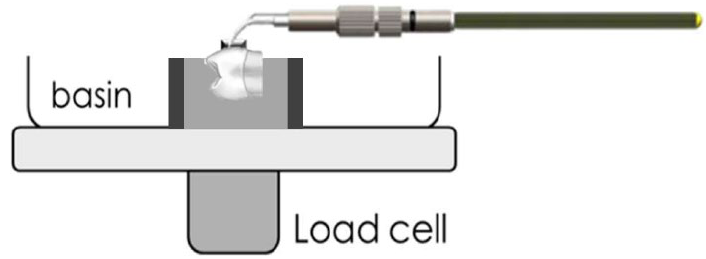
Figure 3. Illustration of applied ultrasonic instrumentation.